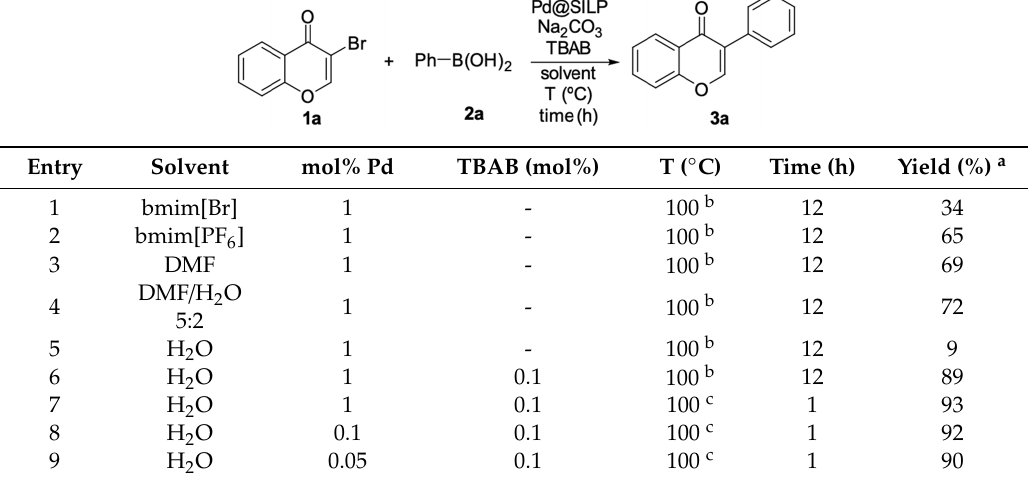
Table 1. Suzuki–Miyaura reaction of 3-bromochromone 1a and phenylboronic acid 2a